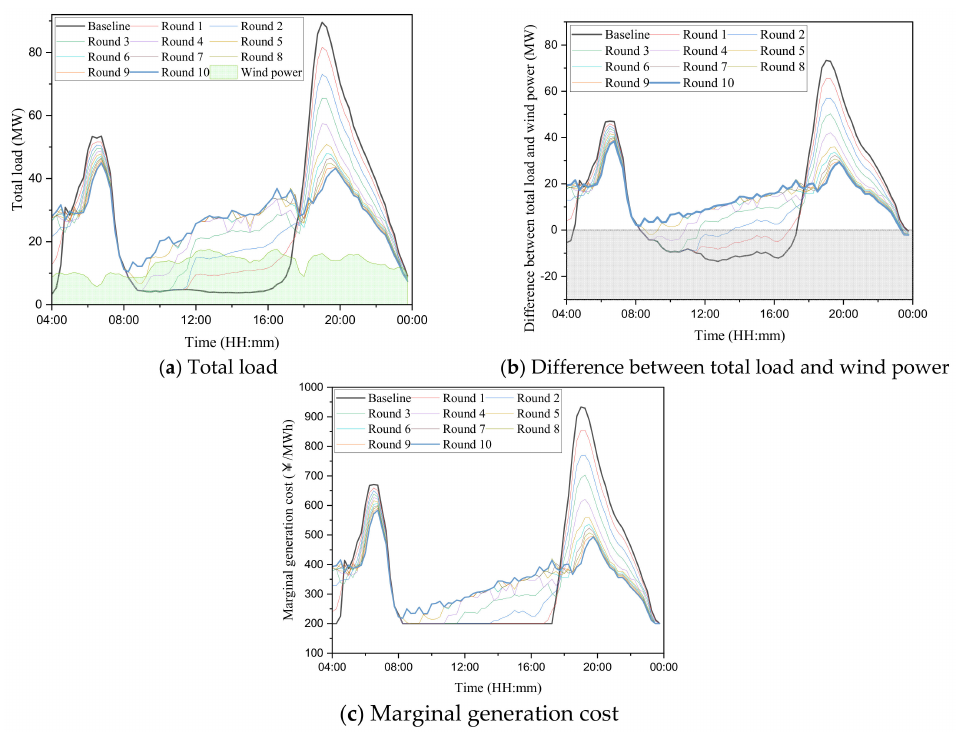
Figure 10. Process display of each